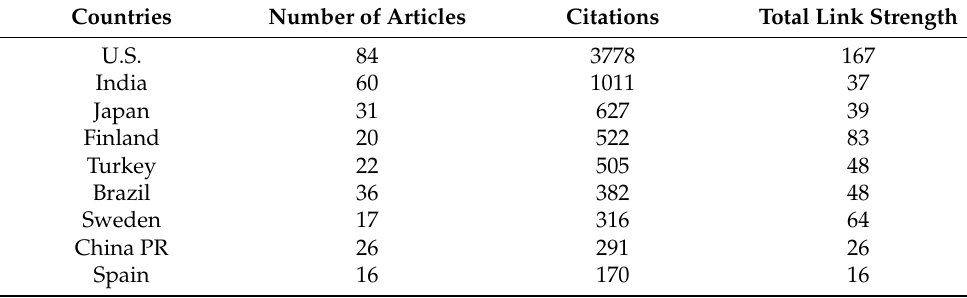
Table 1. Identifying the leading countries that published the highest number of papers related to salivary biomarkers.